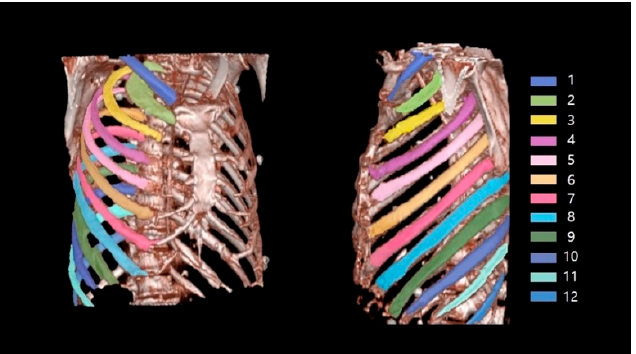
Figure 6 . Verified results of sequence labeling on 3D-rendering rib models with colored annotations.